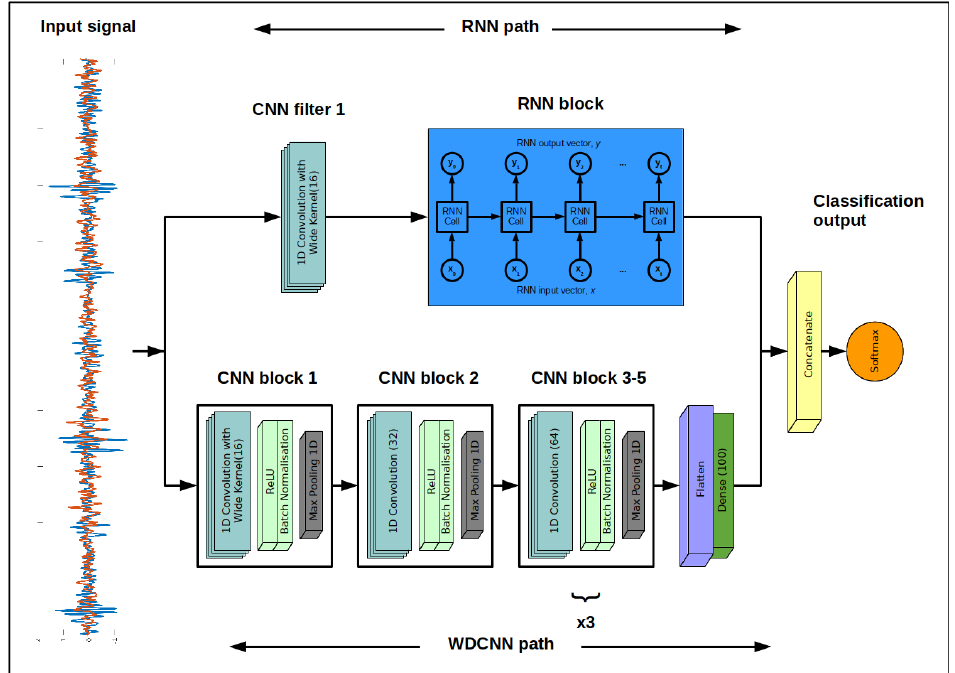
Figure 3. The proposed recurrent neural network with wide first kernel and deep convolutional path